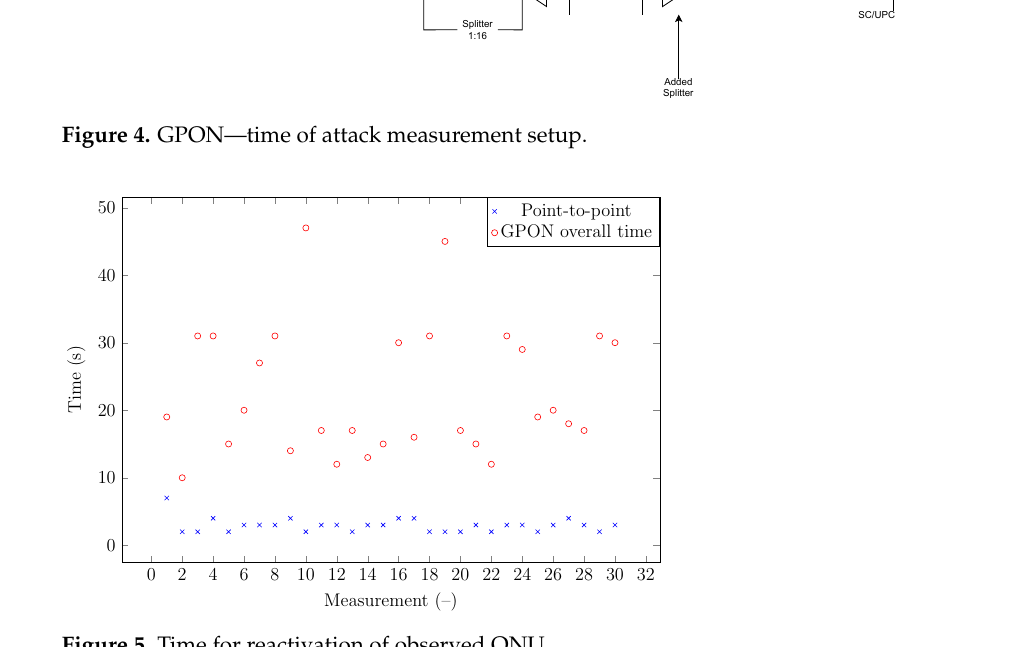
Figure 5. Time for reactivation of observed